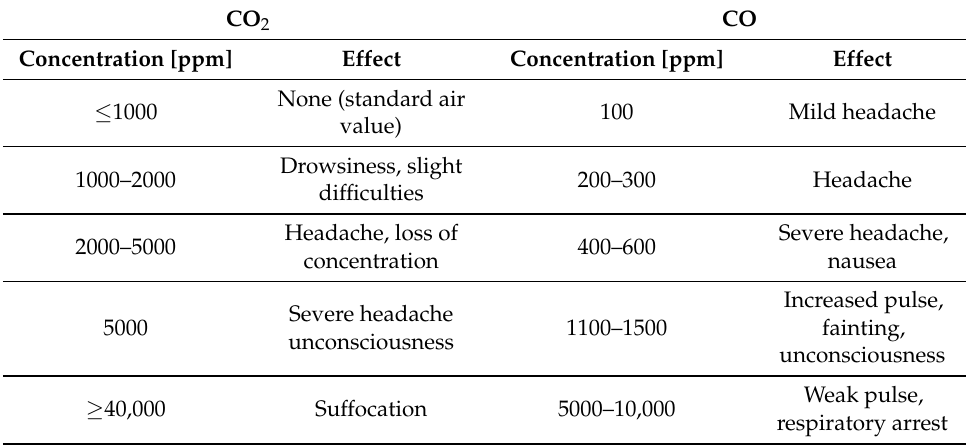
Table 4. Overview of the concentration and its consequences on the human